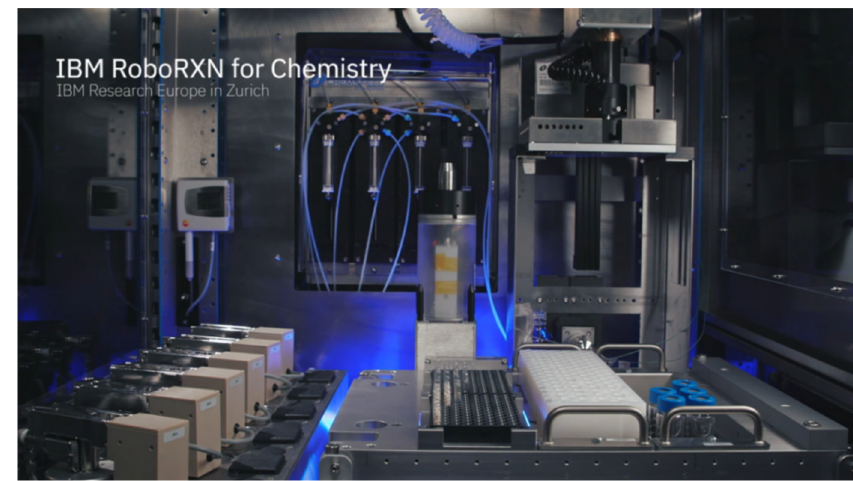
Figure 11. IBM RXN for Chemistry main work and its overall idea.